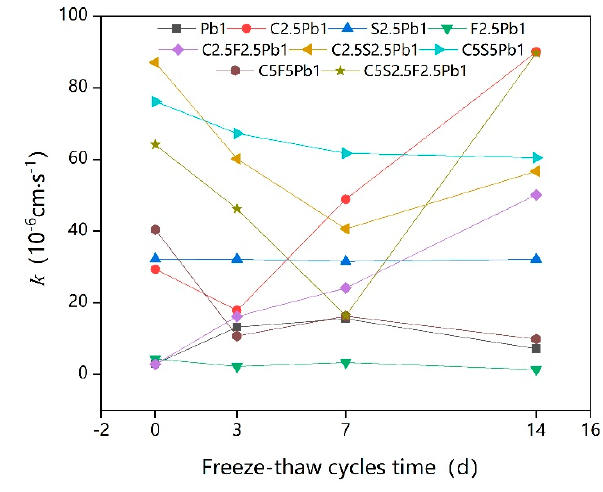
Figure 10. The permeability coefficient (𝑘) of solidified lead-contaminated soils under freeze–thaw cycles.